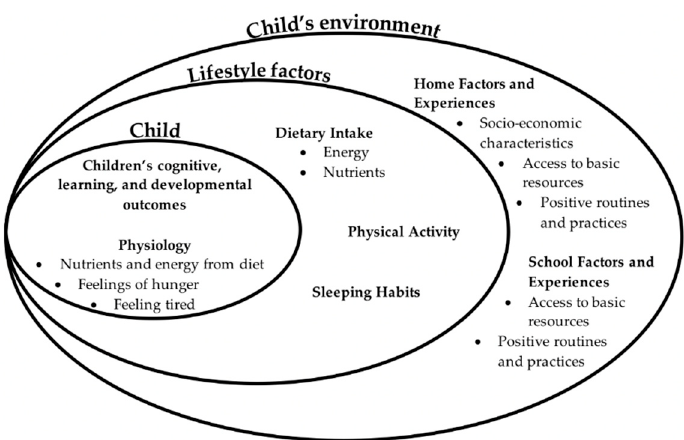
Figure 1. Contributors to children’s cognitive, learning, and other developmental outcomes are described in this ecological model. The inner-most circle represents the child’s own body, where physiological conditions, such as the nutrients and energy provided from meals and snacks, as well as the resulting feelings of hunger or tiredness, may directly influence the ability for cognitive processes. The lifestyle factors affecting the child’s physiology are dietary intake, physical activity, and sleeping habits. The outer-most circle represents the child’s larger environment, such as the home and the school. Socioeconomic factors have a substantial effect on access to basic resources, such as an area to play and be active, the noise level at bed time, and the familial established routines and practices. Likewise, the school’s resources, for instance playgrounds and green space, as well as routines and practices, affect the child’s lifestyle behaviors.